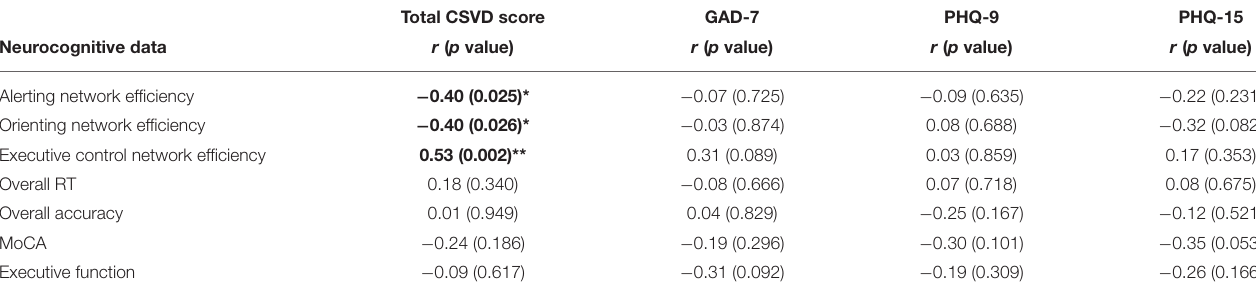
TABLE 5 | Correlations between attention network efficiencies/MoCA and total CSVD score/anxiety, depression, somatic symptom scores in patients with